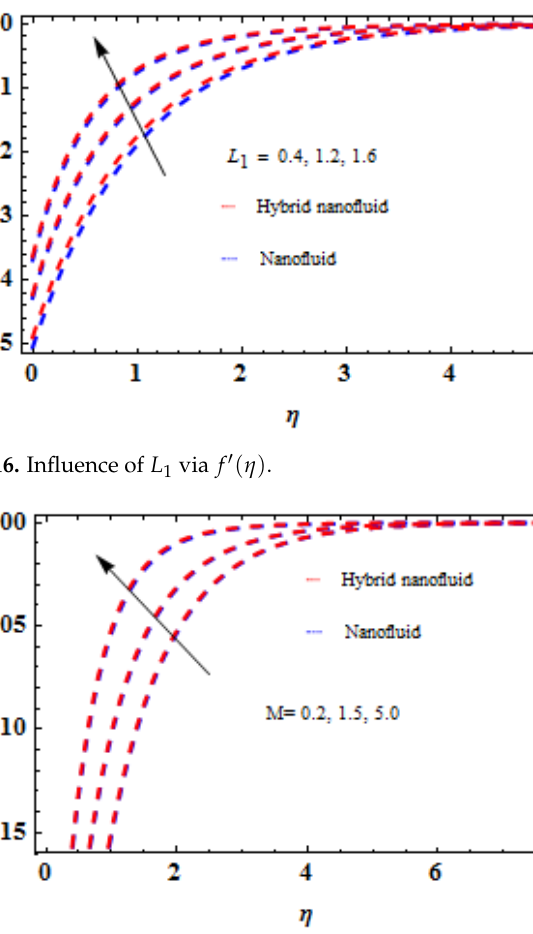
Figure 17. Influence of 𝑀 via 𝑓′(𝜂) .